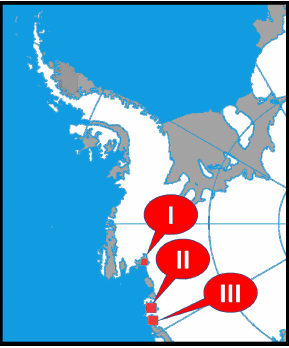
Figure 6. Antarctic sector from which the images were extracted. Square areas I, II, and III correspond to images shown in Figures 7, 8, and 9, respectivelly.